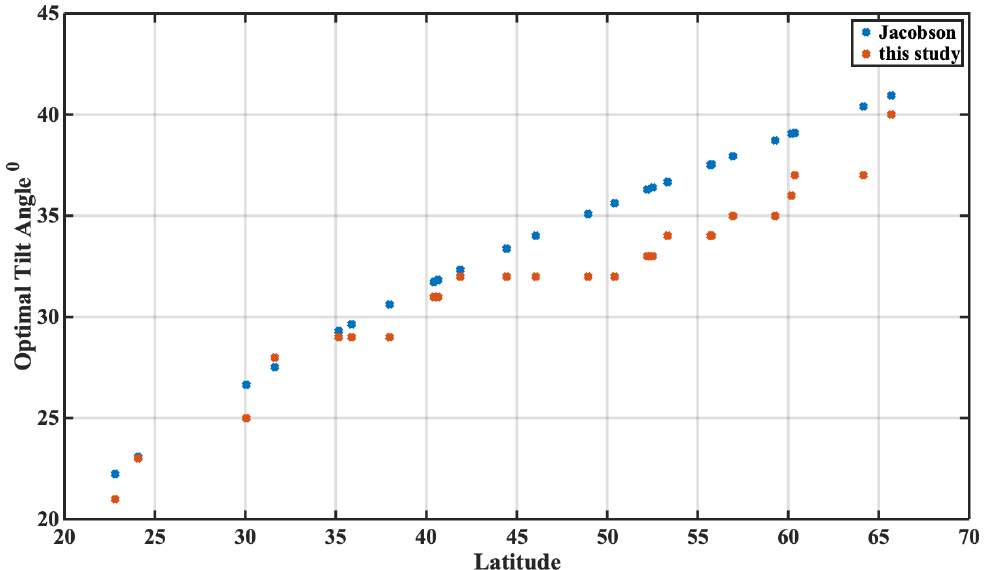
Figure 8. Optimal Tilt angle for the 25 Cities used in the present study, as calculated by Reindl model [31] (red) and as estimated by the equation proposed by Jacobson [24] (blue).